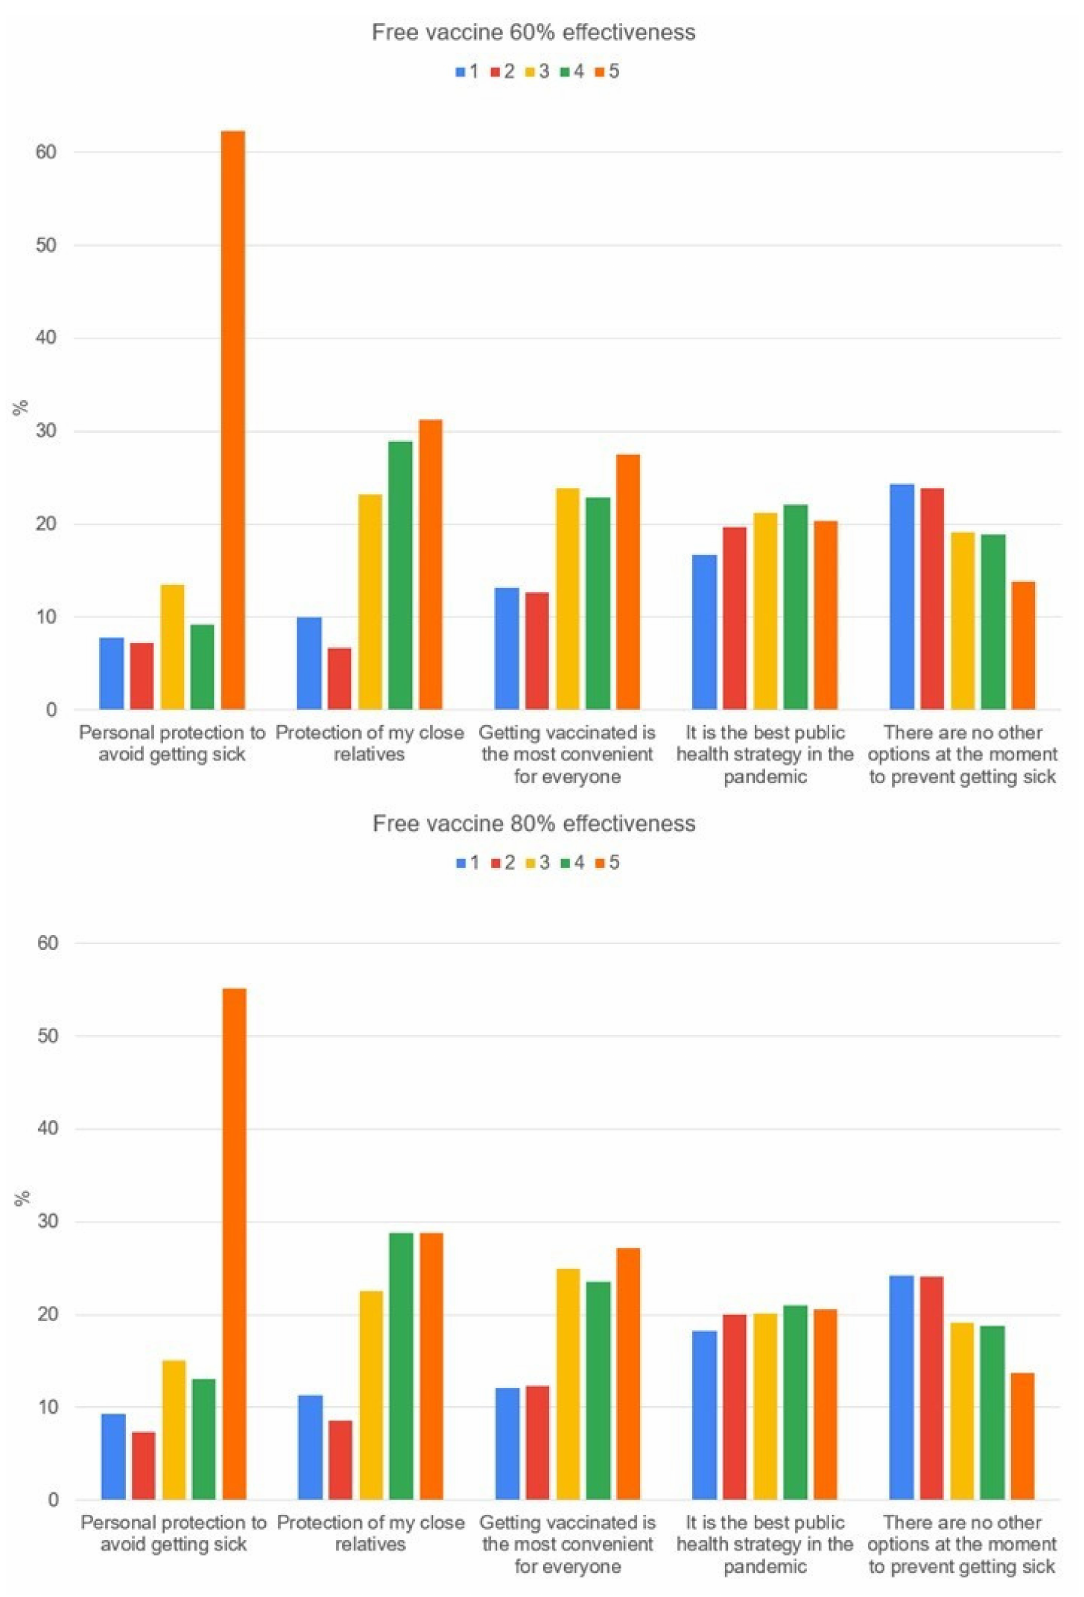
Figure 1. The reason why the participant would accept a free vaccination with an effectiveness of 60% and 80%, against COVID-19, one (1) being the least important and five (5) being the most important (2-4) intermediate